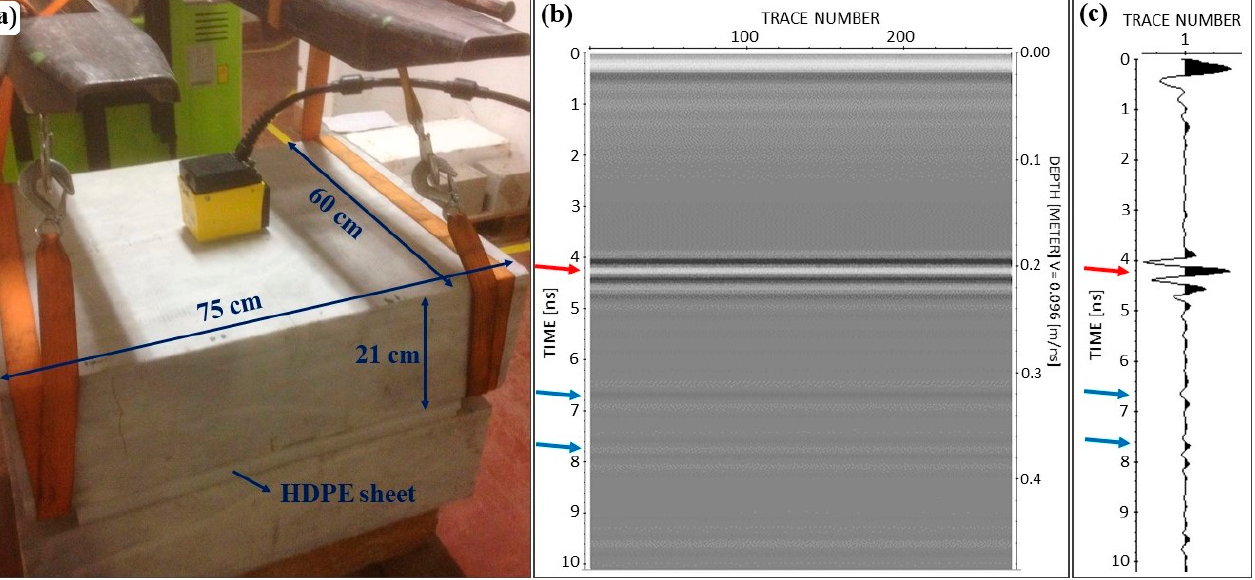
Figure 1. ( a ) Time-triggered GPR data acquisitions on two marble blocks separated with an HDPE layer. ( b ) The processed GPR data. ( c ) A single radar trace extracted from the processed GPR data.